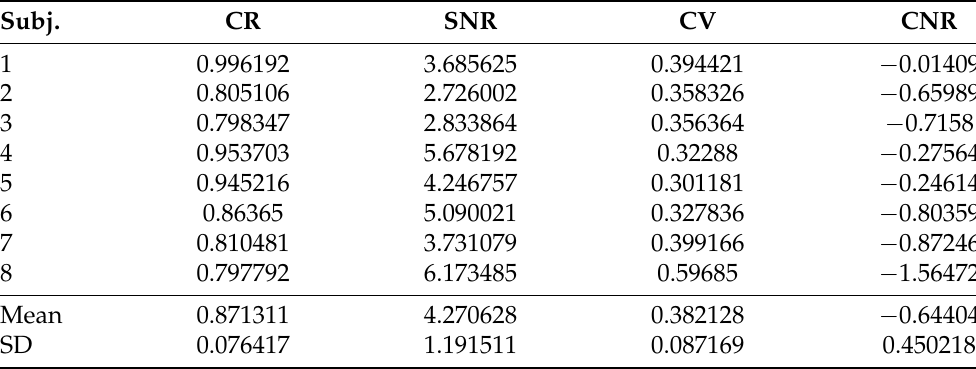
Table 8. Image quality metrics corresponding to MMS-based respiratory-gated reconstructions. CR = contrast ratio, SNR = signal to noise ratio, CV = coefficient of variation, CNR = contrast to noise ratio.